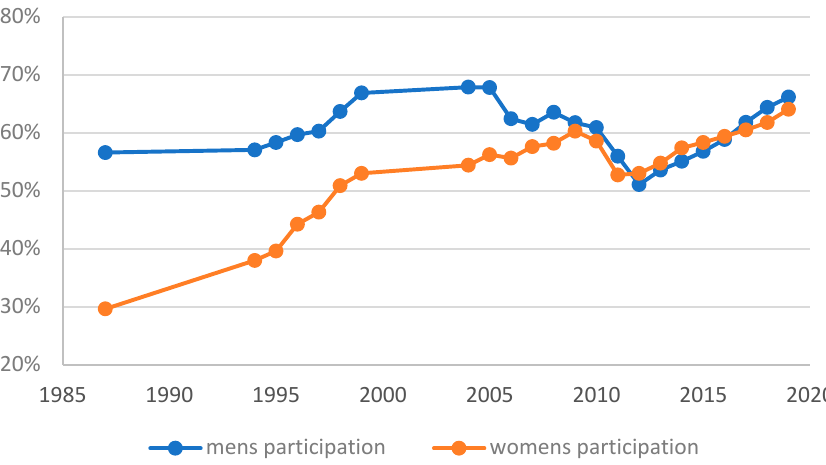
Figure 6. The share of the population in paid employment (excluding the self-employed). Source: